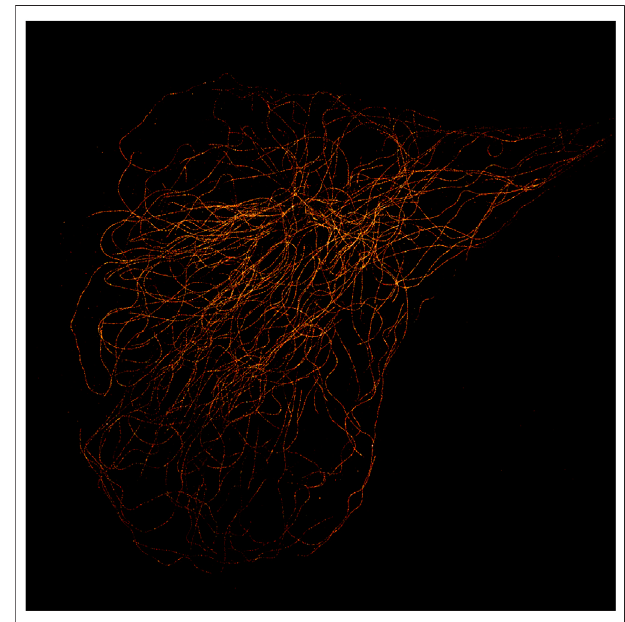
FIGURE 2 | MT STORM image of a control cell (Hs 578Bst cell line). α -Tubulin probed with mouse anti-human primary antibody and goat anti- mouse AlexaFluor 555 as the secondary